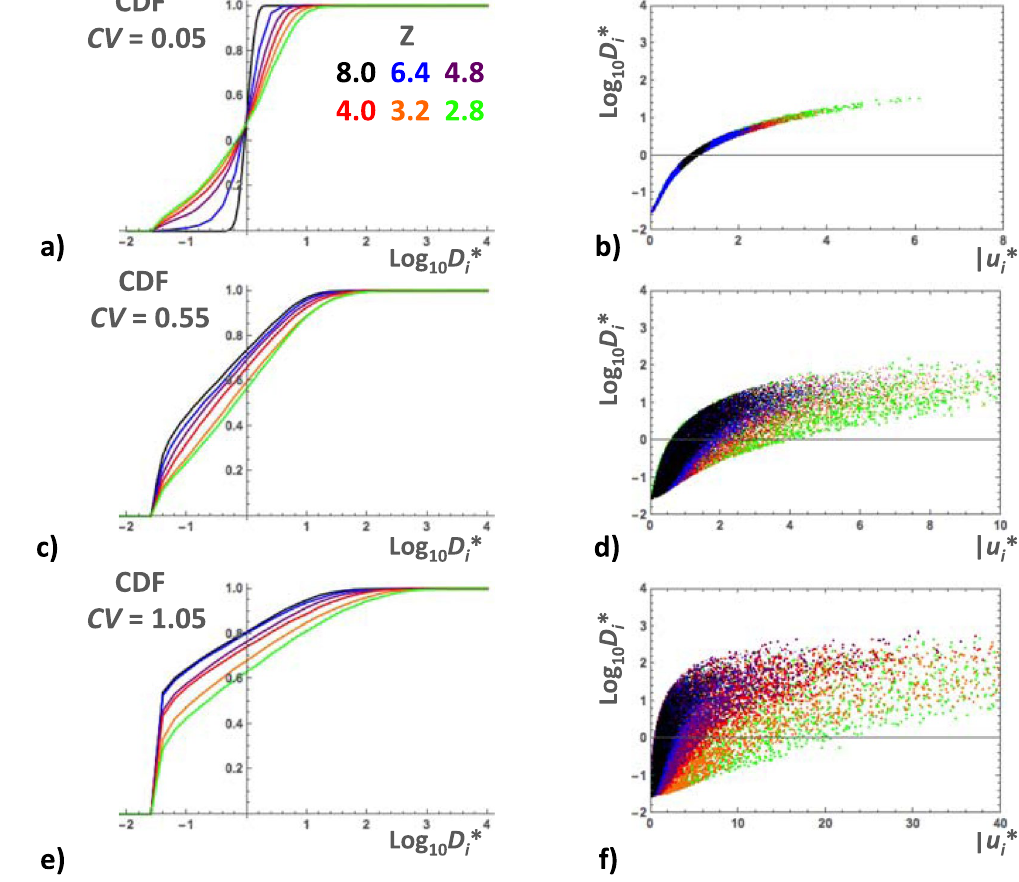
Figure 8. Examples of the cumulative distribution function of Log 10 D i * in BCC simulations with CV = 0.05 ( a ), 0.55 ( c ) and 1.05 ( e ). In each diagram, the CDF’s corresponding to different coordination numbers ( Z = 8.0, 6.4, 4.8, 4.0, 3.2 and 2.8) are represented by colored lines as indicated in the inset. Scatterplot of Log 10 D i * versus | u i * | for the same simulations, CV = 0.05 ( b ), 0.55 ( d ) and 1.05 ( f ). Layers of colored data-points are superposed with the ones corresponding to Z = 8 on top and Z = 2.8 at the bottom. (See text for more